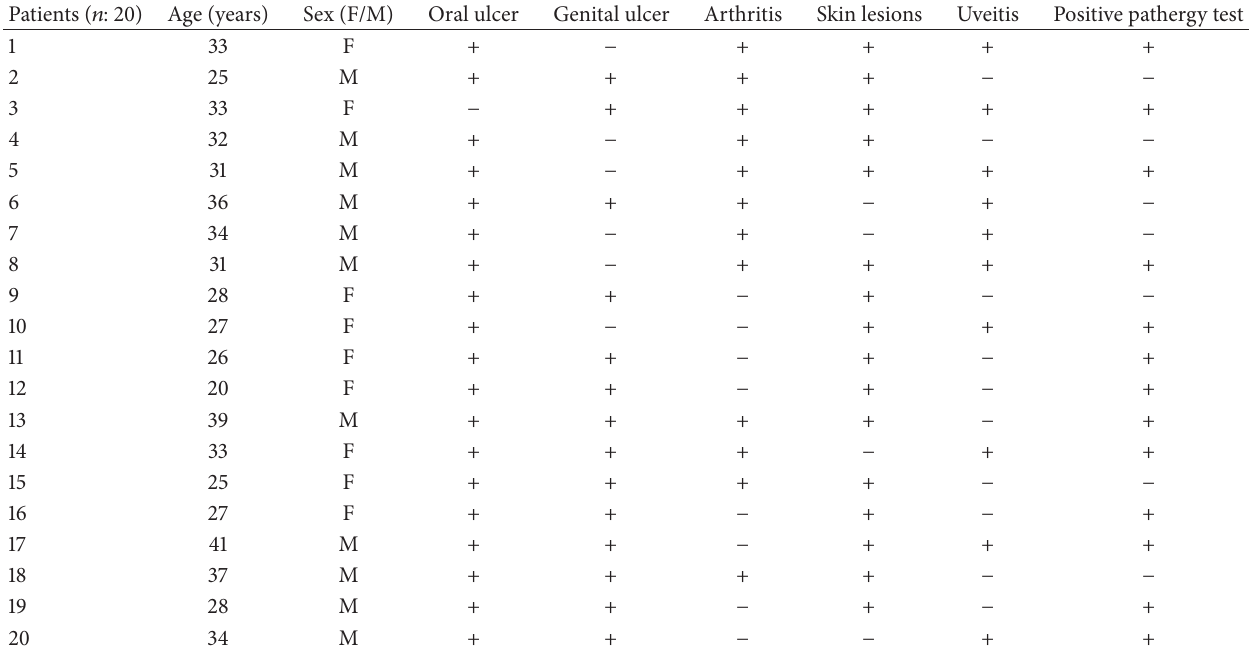
Table 1: Demographic and clinical features of active BD